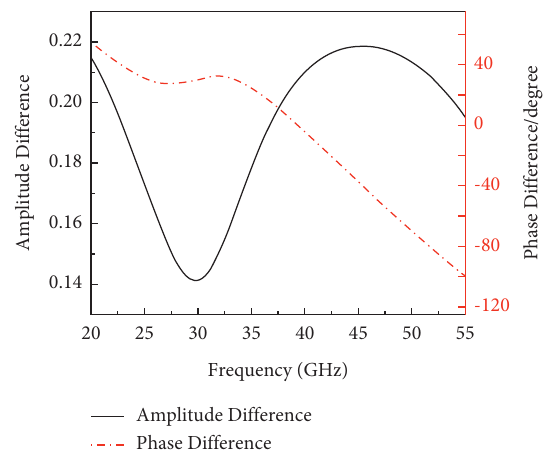
Figure 18: Amplitude (left column) and phase (right column) differences calculated by the multiple reflection